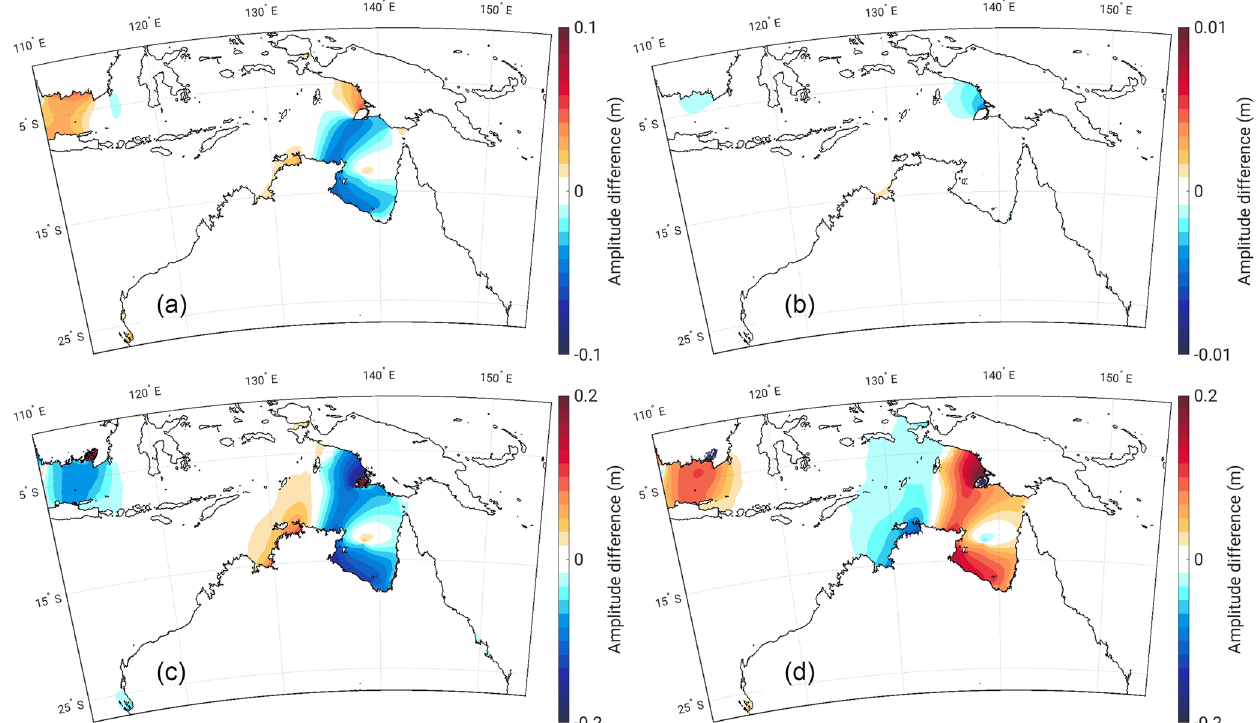
Figure 10. Same as Fig. 5 but for the K 1